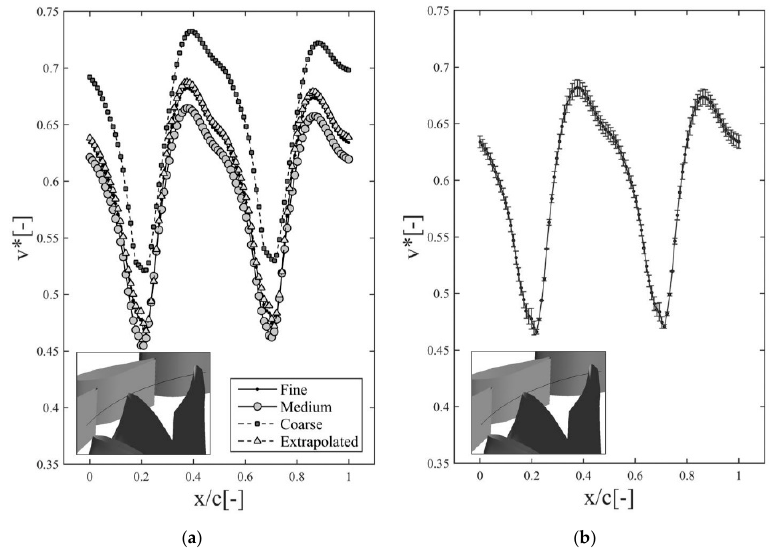
Figure 4. Uncertainty in velocity measurement at the outlet of the GV. ( a ) Different mesh schemes; ( b ) Discretization error bar.